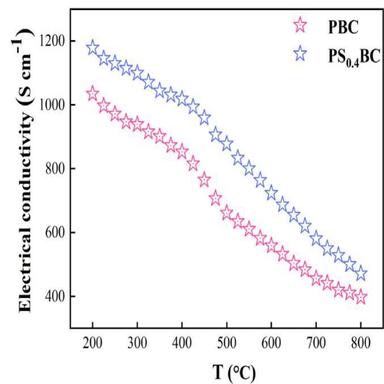
The temperature-dependent electrical conductivity of PBC and PS0.4BC in an air atmosphere.